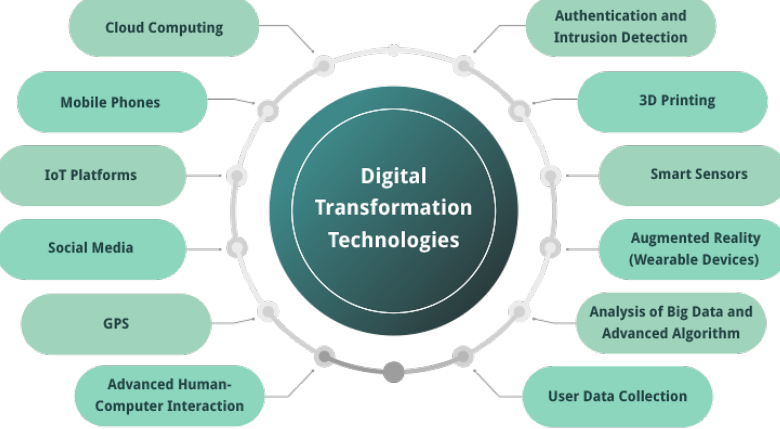
Figure 5. Digital transformation technologies according to GOV.SA